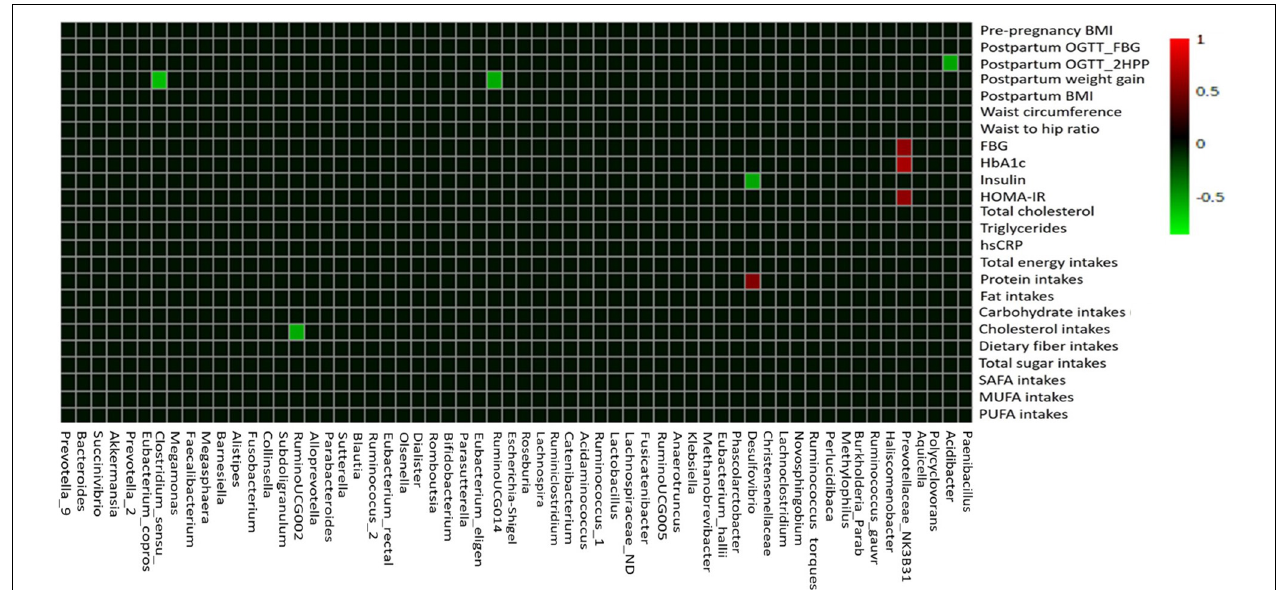
FIGURE 6 | The correlation heat map of the gut microbiota composition with macronutrient intake, anthropometric, and glycemic control variables. Pearson’s correlation coefficient between top 60 gut microbial taxa at the genus level and macronutrient intake, anthropometric, and glycemic control parameters are indicated by colors (red, positive; green, negative). BMI, body mass index; OGTT, oral glucose tolerance test; FBG, fasting blood glucose; 2HPP, 2-h postprandial blood glucose; HbAIc, glycosylated hemoglobin; HOMA-IR, homeostasis model assessment-estimated insulin resistance; hs-CRP, high-sensitivity C-reactive protein; SAFA, saturated fatty acids; PUFA, polyunsaturated fatty acids; MUFA, monounsaturated fatty